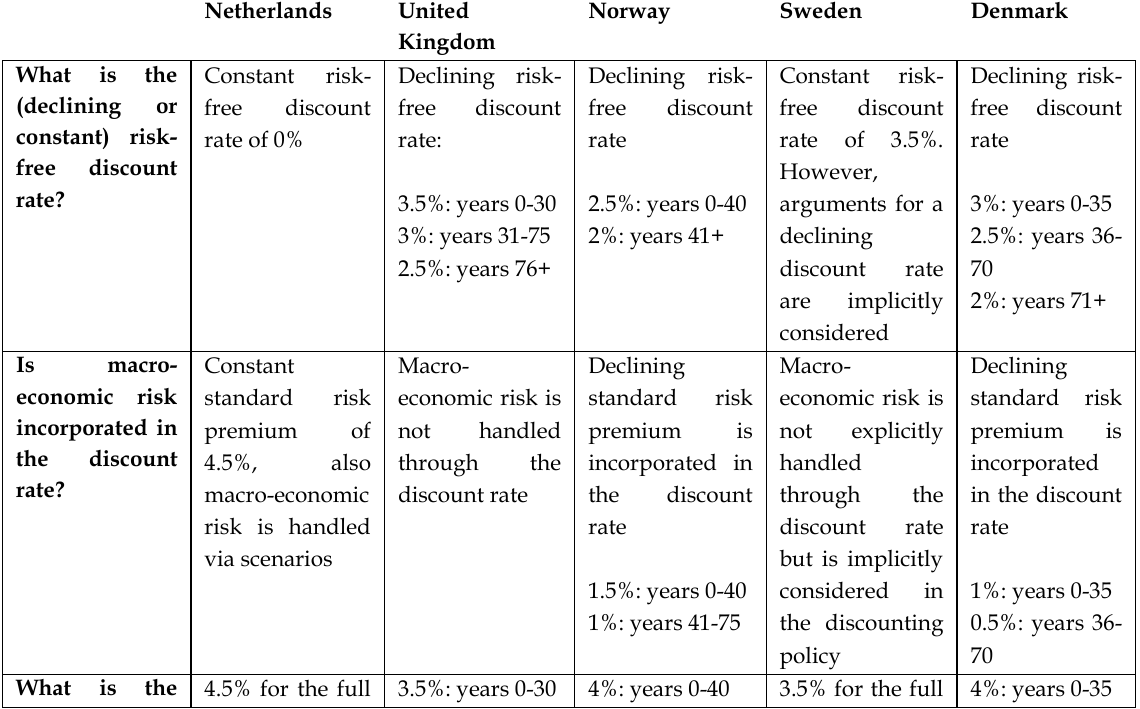
Characteristics of discounting policies for the five